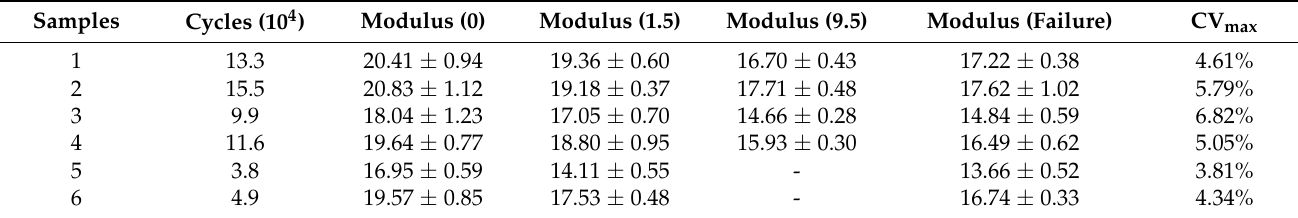
Table 1. Fatigue life, reduced modulus and CV% of the